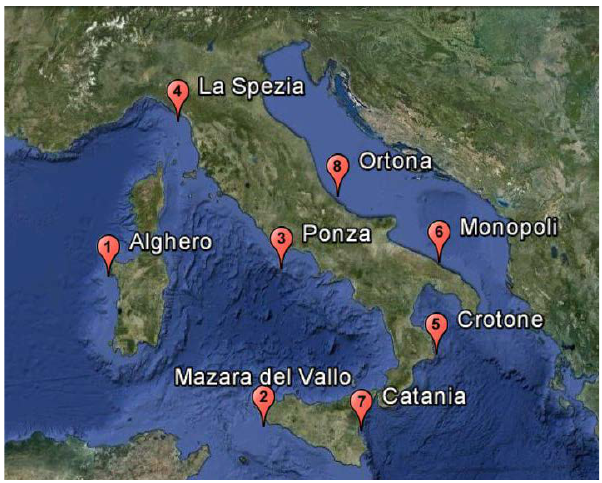
Figure 2. Case study